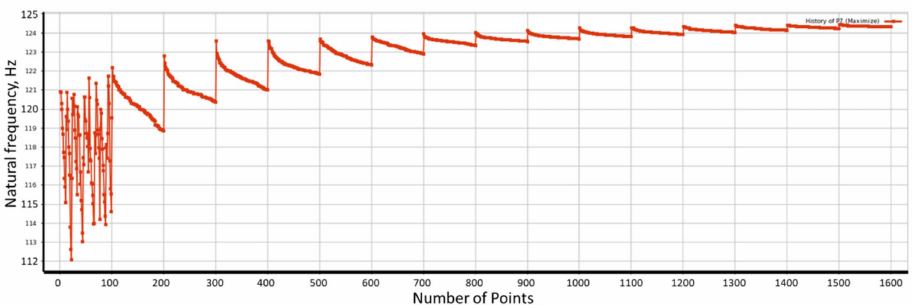
Figure 20. Convergence history for the first mode’s natural frequency.